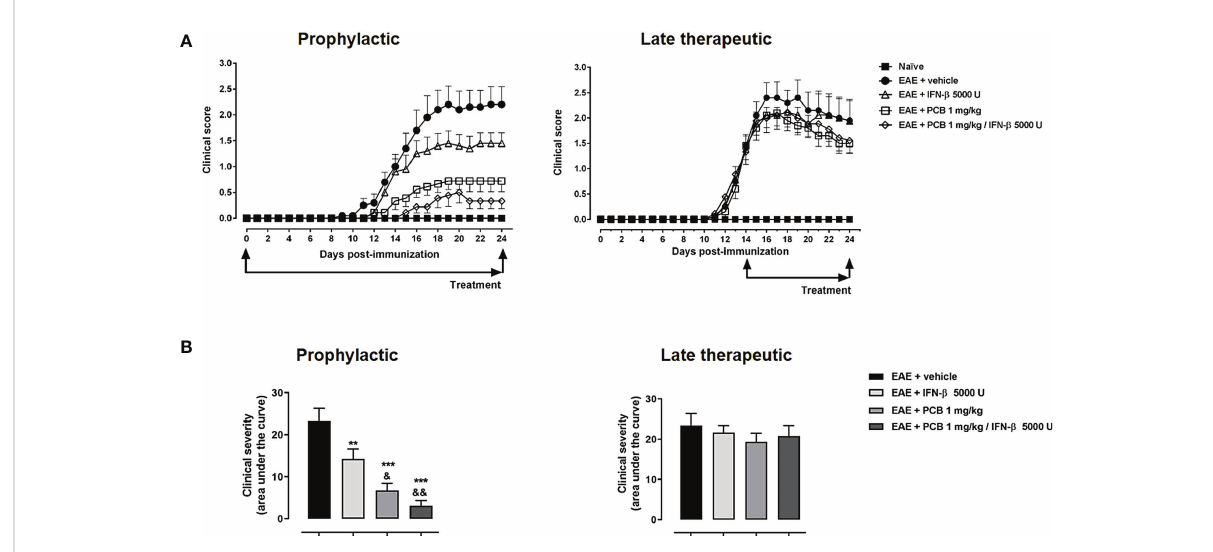
FIGURE 6 Effect of the treatment with the combination PCB/IFN- b and each compound individually on the clinical progression of EAE mice. (A) Daily clinical assessment of the mice. (B) Clinical severity determined by the area under the curve (in arbitrary units). MOG 35 – 55 immunized mice were treated either with oral PCB at 1 mg/kg daily (once a day), with subcutaneous IFN- b at 5000 U every other day, or with their combination, initiating at day 0 (prophylactic schedule), or after the occurrence of the fi rst disease symptoms at day 14 post-induction (late therapeutic schedule), lasting until day 24 post-immunization. A numeric scale with the ascending graveness was used to score every day the clinical signs of the mice, ranging from 0 (no disease) to 5 (death). The naïve group (non-immunized animals) remained healthful during the entire study period (score 0). Data are expressed as the mean ± S.E.M. (n=9-10 per group). The ampersand (&) and asterisk (*) are indicative of signi fi cant differences with IFN- b -treated or vehicle-treated EAE mice, respectively (**p<0.01, ***p<0.001, & p<0.05, && p<0.01, ANOVA + Newman-Keuls